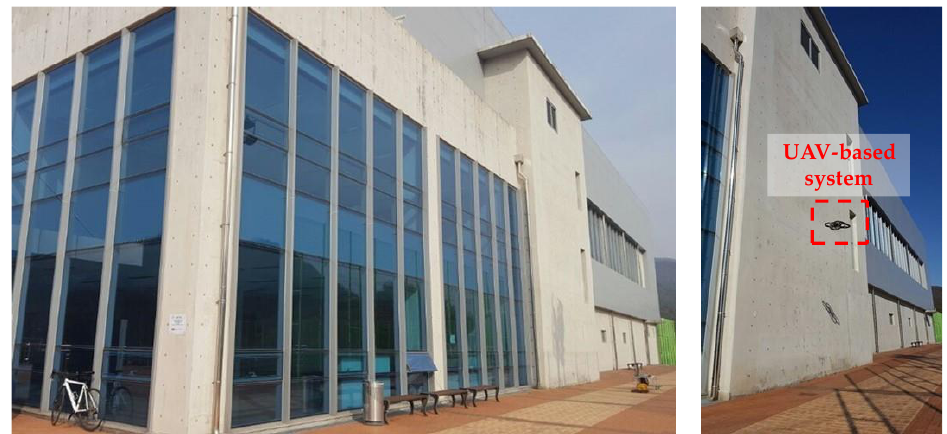
Figure 9. Experimental validation using concrete wall.